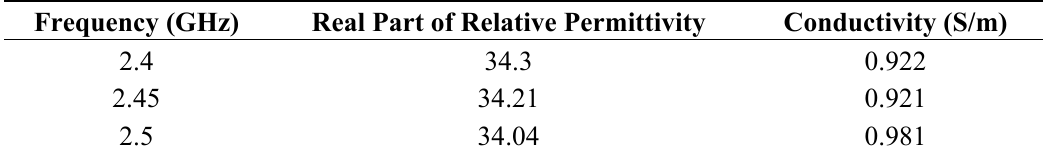
Table 1. The measured dielectric properties of the anthropomorphic